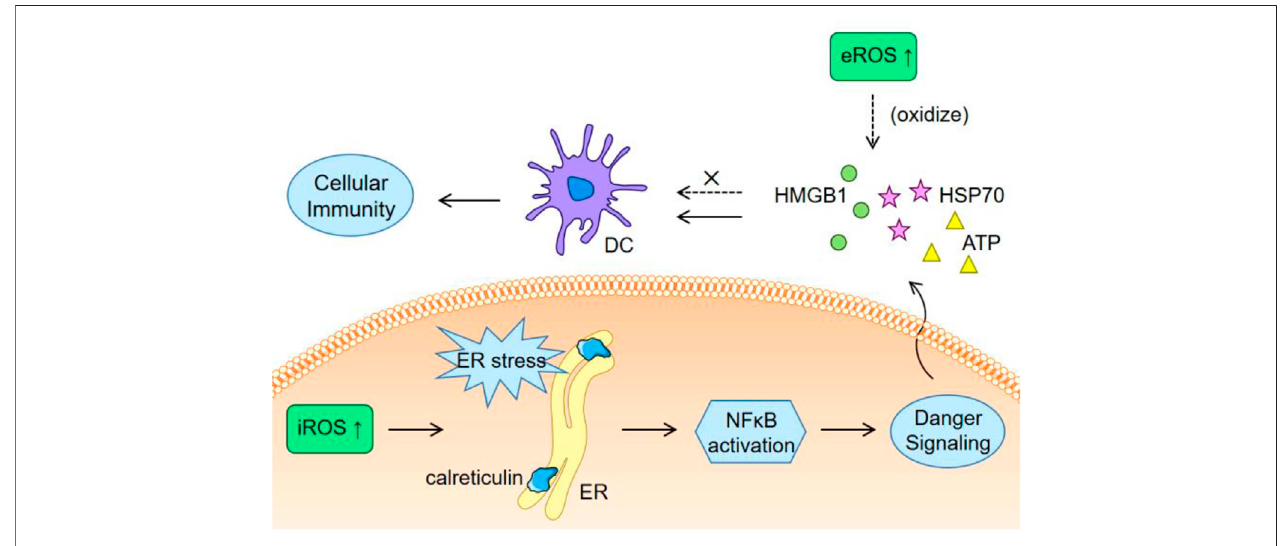
FIGURE 1 | Schematic illustration of the different effects of iROS and eROS on